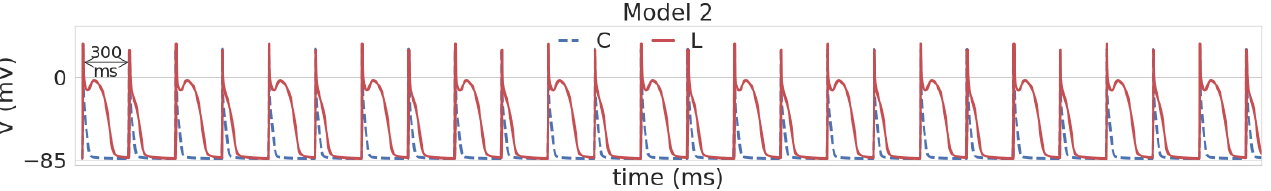
Figure 3. Alternation of spike-and-dome and triangular AP shapes in Model 2 under leptin (solid red line) compared to triangular control APs (dashed blue line) at BCL 300